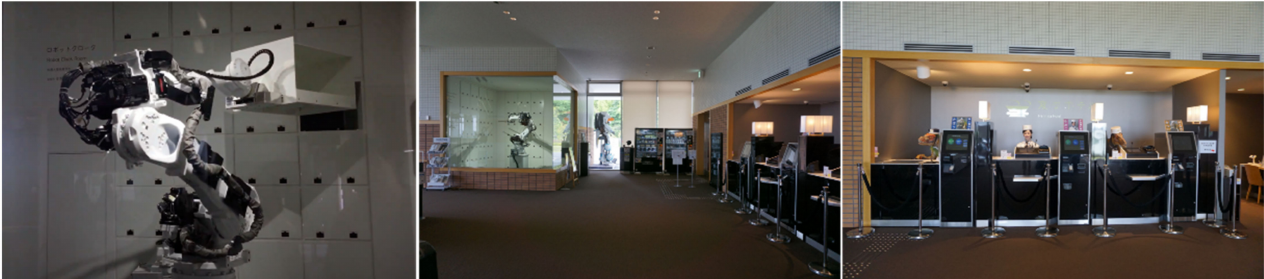
Figure 1. Luggage storage robot and reception robot for check-in/out at the Henn-na Hotel in